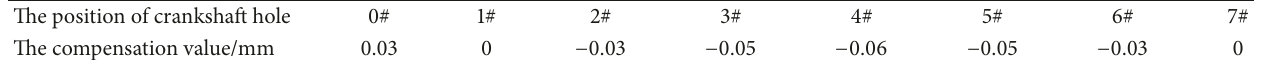
Table 2: The compensation value of crankshaft hole center.